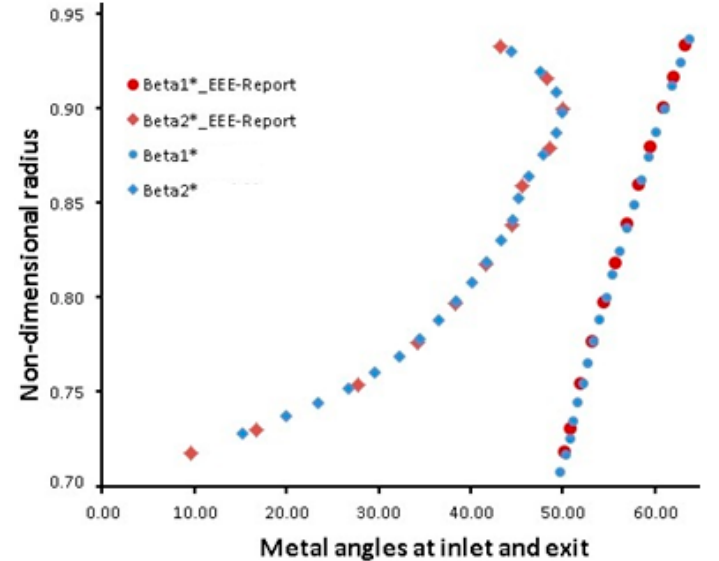
Figure 17. Axisymmetric views of 3D domains for ducted axial 10 ‐ stage HPC, 5 ‐ stage LPT, solo LPC rotor, centrifugal compressor novel configuration, and unducted rotors without nose at hub. Grid dependency for listed examples of configurations are also listed in the bottom